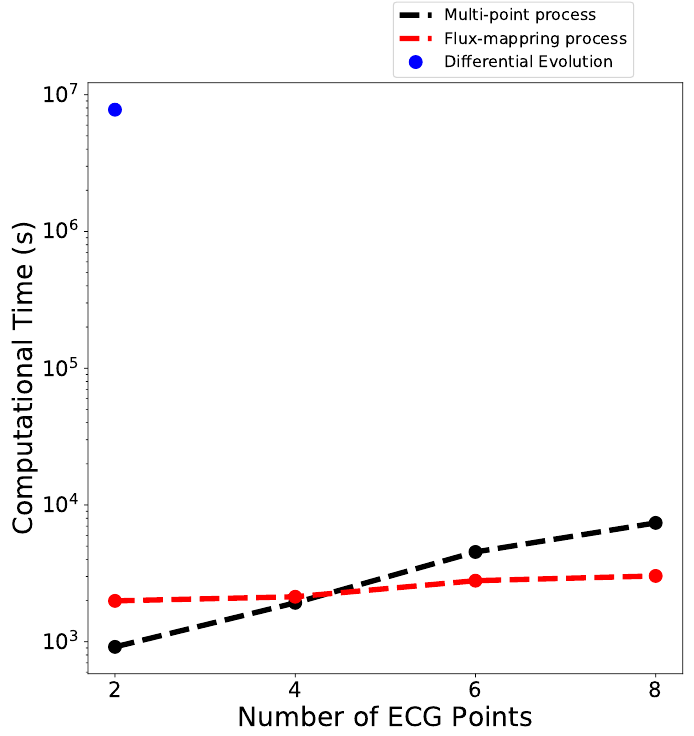
Figure 20. Computational time comparison of optimisation